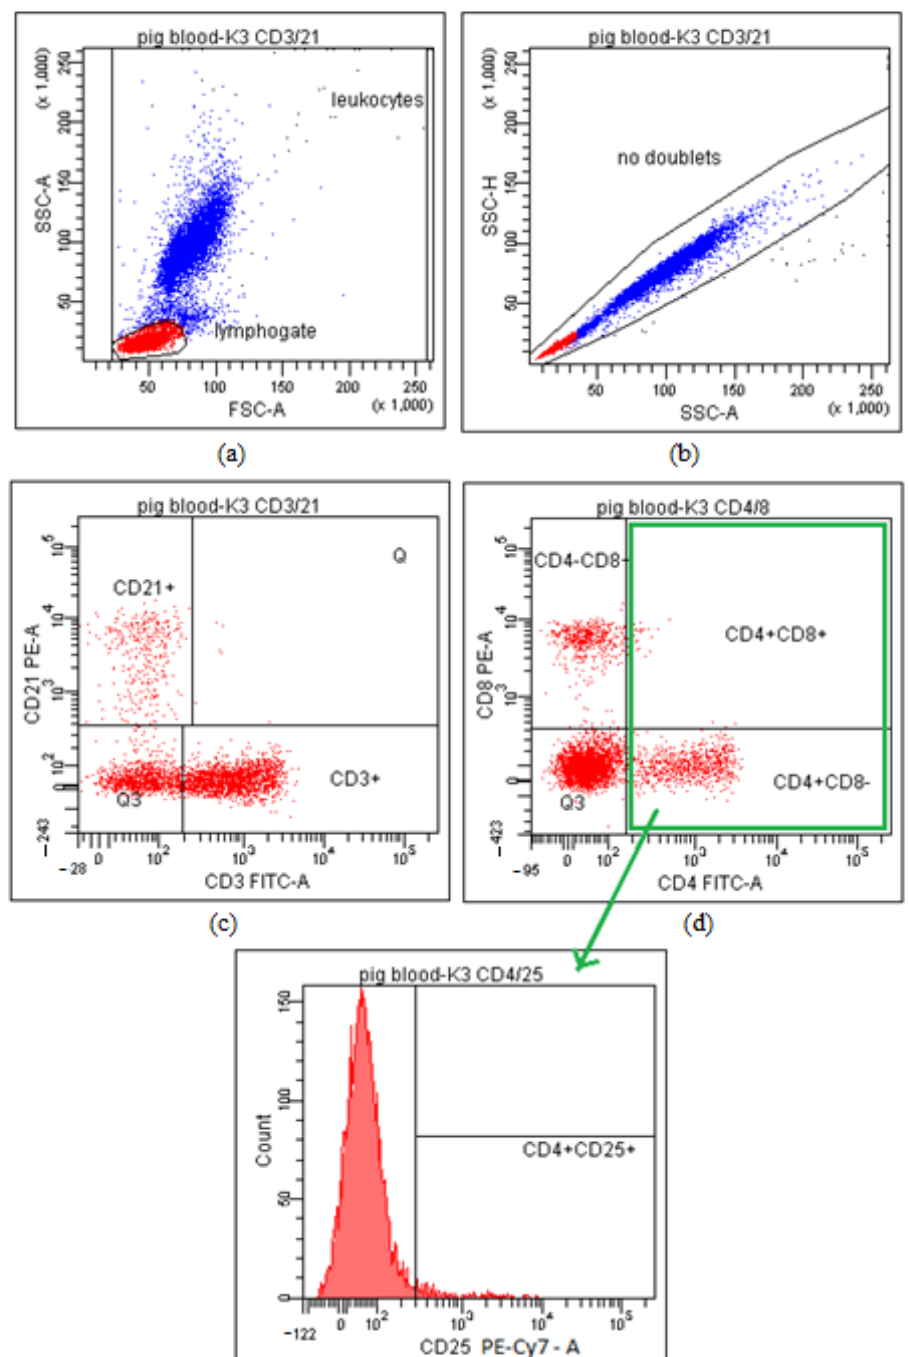
Figure 1. Gating strategy: ( a ) determination of the position of lymphocytes (red) on the basic dot plot (FSC-A versus SSC-A); ( b ) removing doublets and agglomerates from the analysis; ( c ) analysis of the representation of CD3+ and CD21+ lymphocytes; ( d ) analysis of the representation of CD4+ and CD8+ lymphocytes; ( e ) determination of the representation of CD4+CD25+ lymphocytes on histogram from CD4+ positive cells (gated with green).